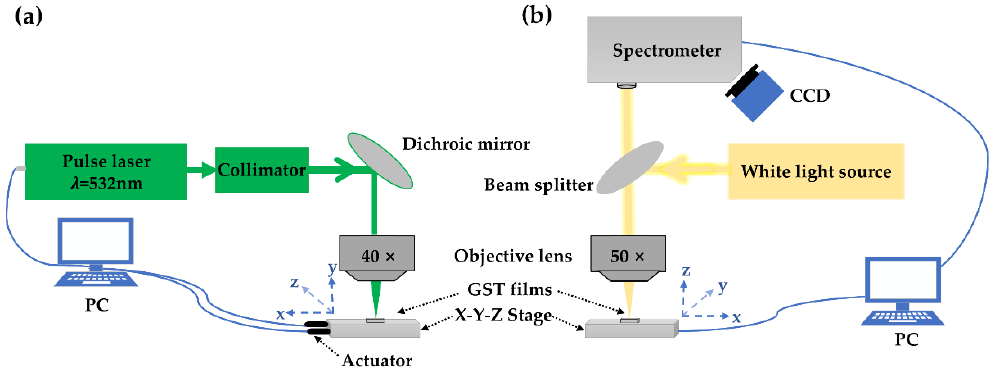
Figure 1. Schematic of the experimental set-up, ( a ) the 532 nm laser beam propagated along the green line for phase transition experiment with GST films; ( b ) the home-built micro-area reflection measurement system for GST films.